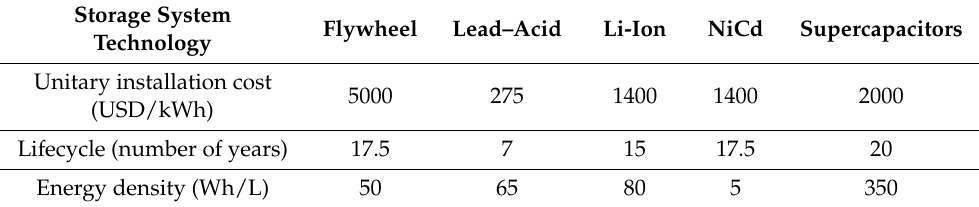
Table 1. The main characteristics of electric storage systems